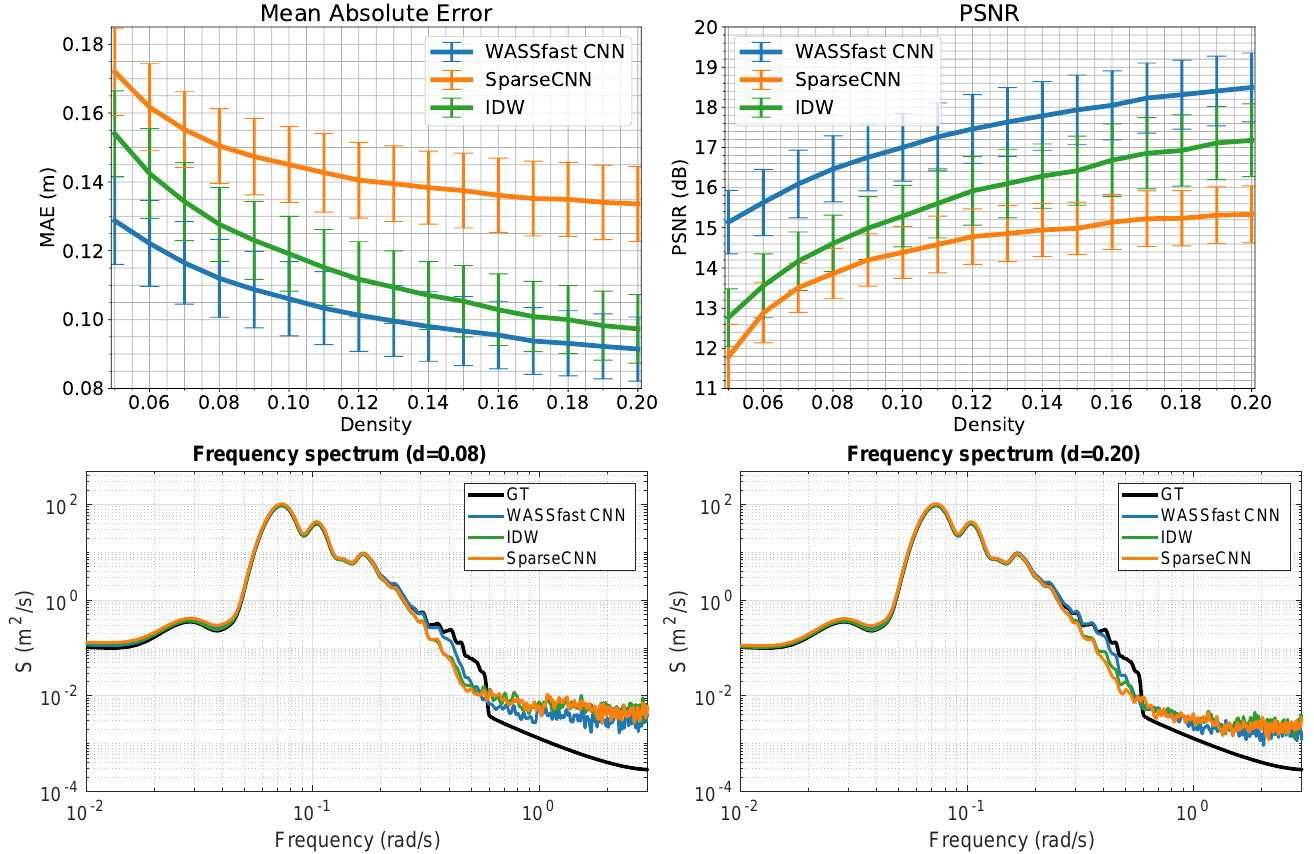
Figure 7. Top row: comparison of the mean absolute error ( left ) and peak signal to noise ratio ( right ) of the surface reconstructed with WASSfast CNN, SparseCnn and IDW varying the sample density. Bottom row: frequency spectra of timeseries extracted from a grid center when reconstructing a synthetic sequence at different sampling